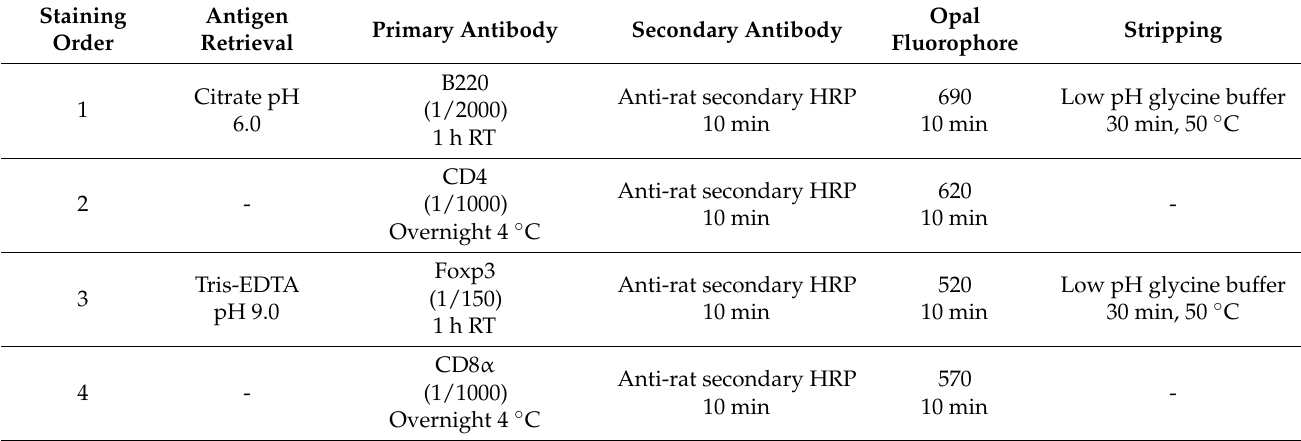
Table 2. Multiplex staining panel for the identification of T and B cell